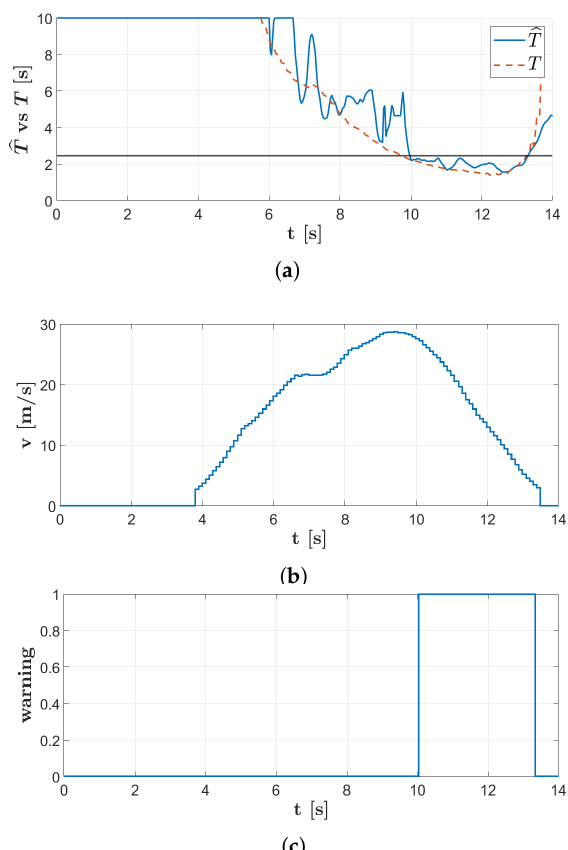
Figure 8. Results of the experimental validation in a CCRS scenario. ( a ) Time-history of the estimated Time-To-Collision, (cid:98) T , compared to the estimated through the RADAR sensor, T . The warning threshold is shown as a constant horizontal line. ( b ) Time-history of the vehicle speed. ( c ) Time- history of the Forward Collision Warning